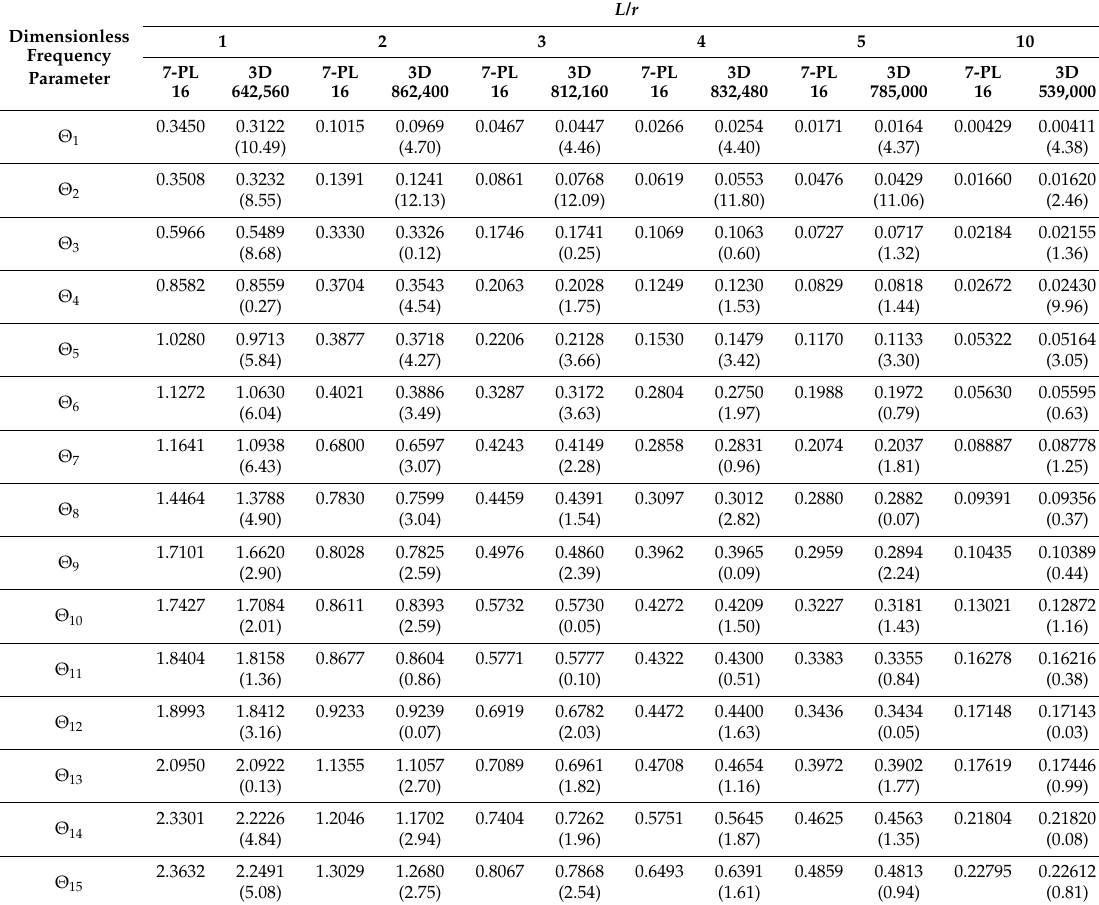
Table 21. Dimensionless parameter Θ for a quarter of cylinder with linear thickness variation, r / h = 10. Dimensionless Frequency